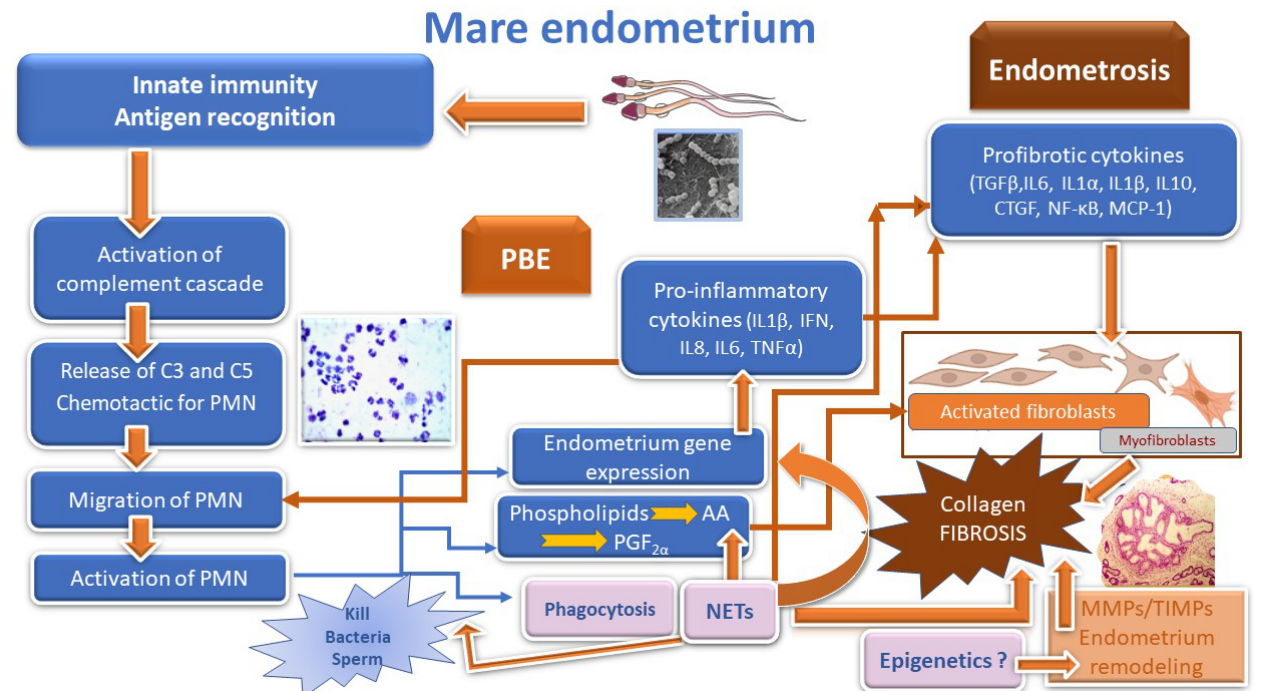
Figure 1. Physiology of post breeding endometritis (PBE) and pathophysiology of endometrosis. C, complement; PMN, polymorphonuclear leukocytes; NETs, neutrophil extracellular traps; AA, arachidonic acid; PGF 2α , prostaglandin F 2α ; MMPs, matrix metalloproteinases; TIMPs, tissue inhibitors of metalloproteinases; IL, interleukin; IFN, interferon; TNFα , tumor necrosis factor α; TGF β , transforming growth factor β ; CTGF, connective tissue growth factor; NF- κB , nuclear factor kappa B; MCP-1, monocyte chemoattractant protein-1.